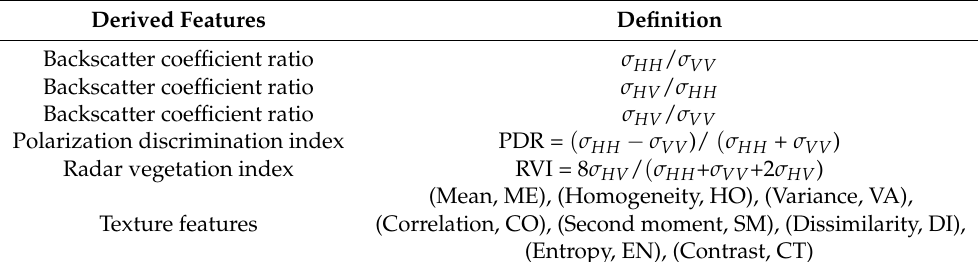
Table 2. The information of backscattering